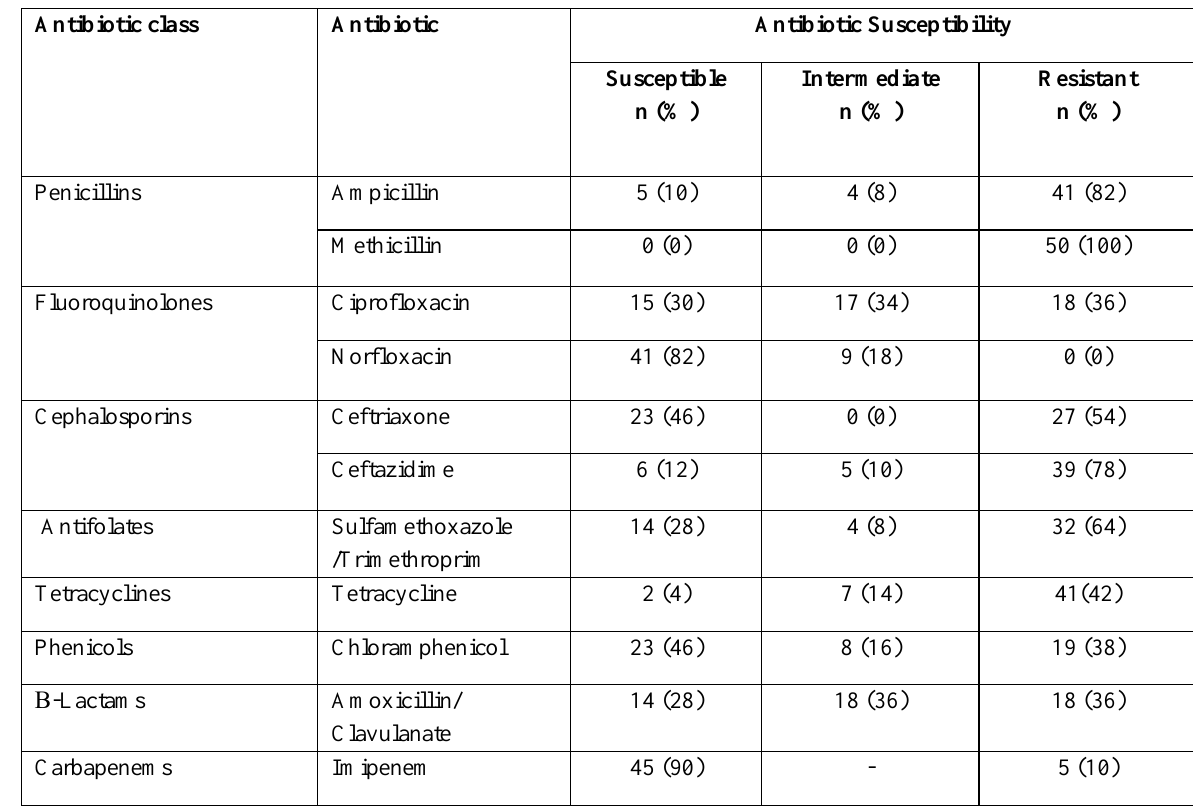
Table 2. Antibiotic susceptibility profile of Salmonella enterica isolates based on disc diffusion method.